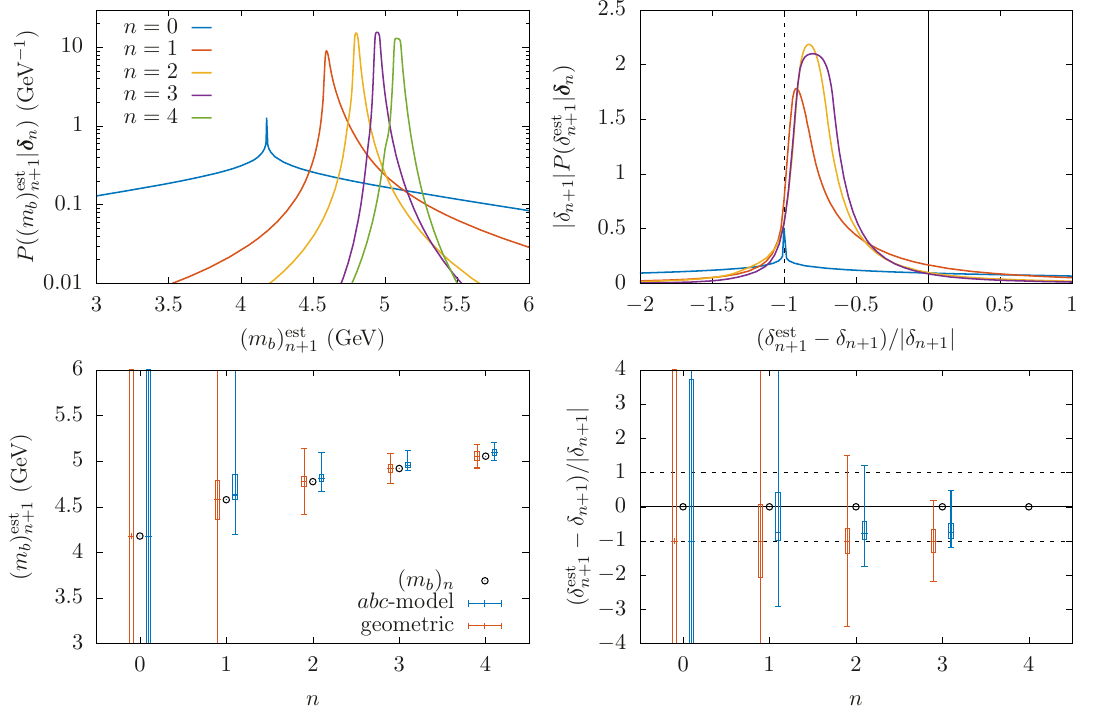
Figure 26 . Top left panel: the probability distributions from abc -model for the on-shell bottom quark mass ( m ) est evaluated at µ = m and for different values of n . Top right panel: the same b R b n +1 distributions normalised to the exact N n +1 LO correction. Bottom left panel: the median (plus), 68% CI (errorbox) and 95% CI (errorbar) for the posterior of ( m ) est , computed from the abc b n +1 (blue) and geometric (red) models using information on the previous orders. The exact values of ( m ) are shown as black circles. Bottom right panel: CIs scaled to the exact N n +1 LO b n